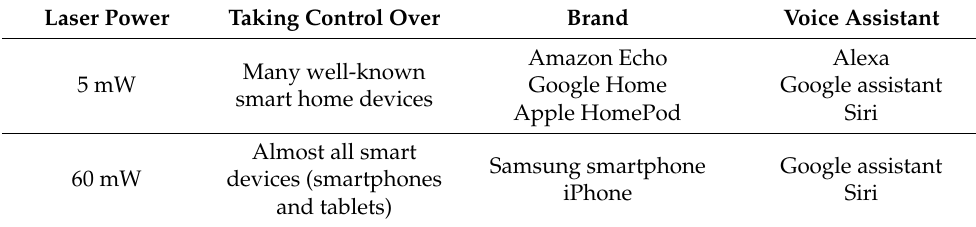
Table 1. Laser power information. Laser Power Taking Control Over Brand Voice Assistant Many 5 mW